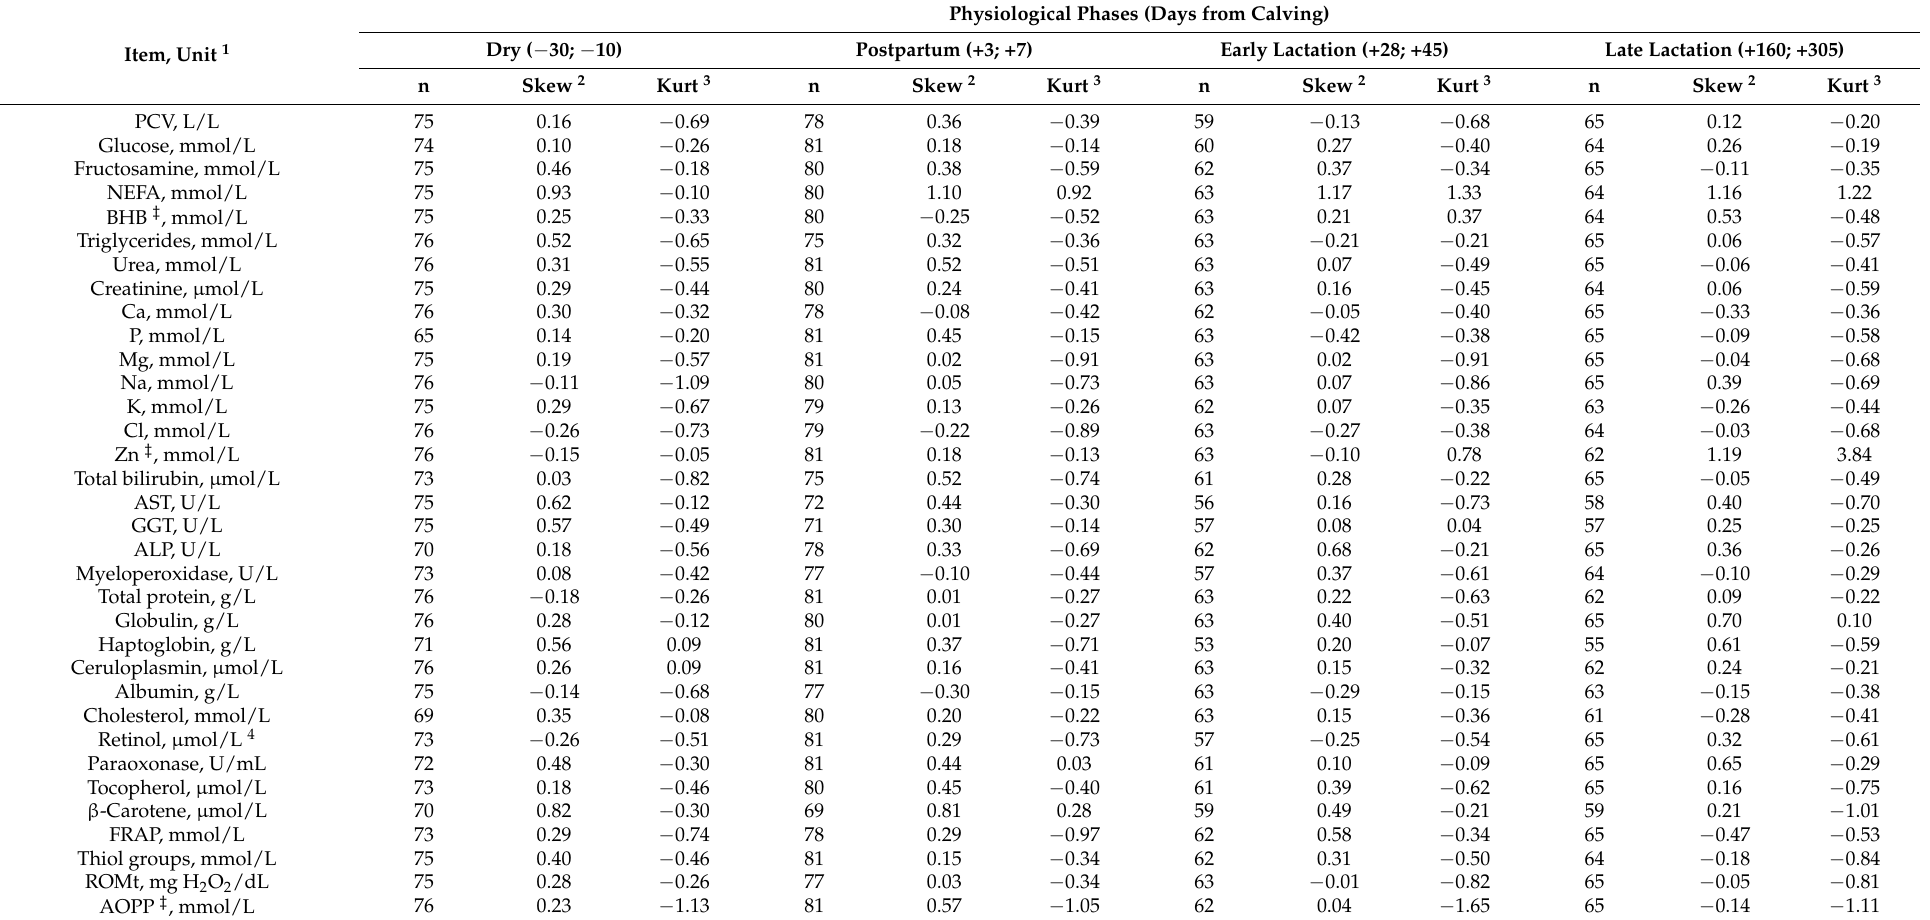
Table 2. Samples included in the statistical analysis and skewness and kurtosis values for plasma analytes assessed in healthy, high welfare raised multiparous Holstein dairy cows during the pivotal stages of the lactation